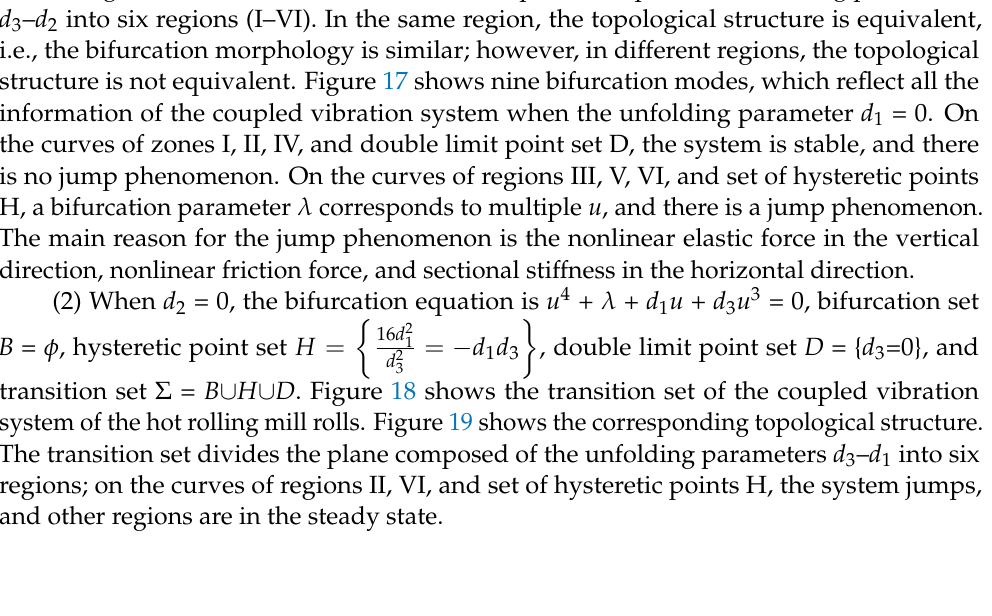
Figure 17. Topological structure of different regions in the transition set when d 1 = 0.